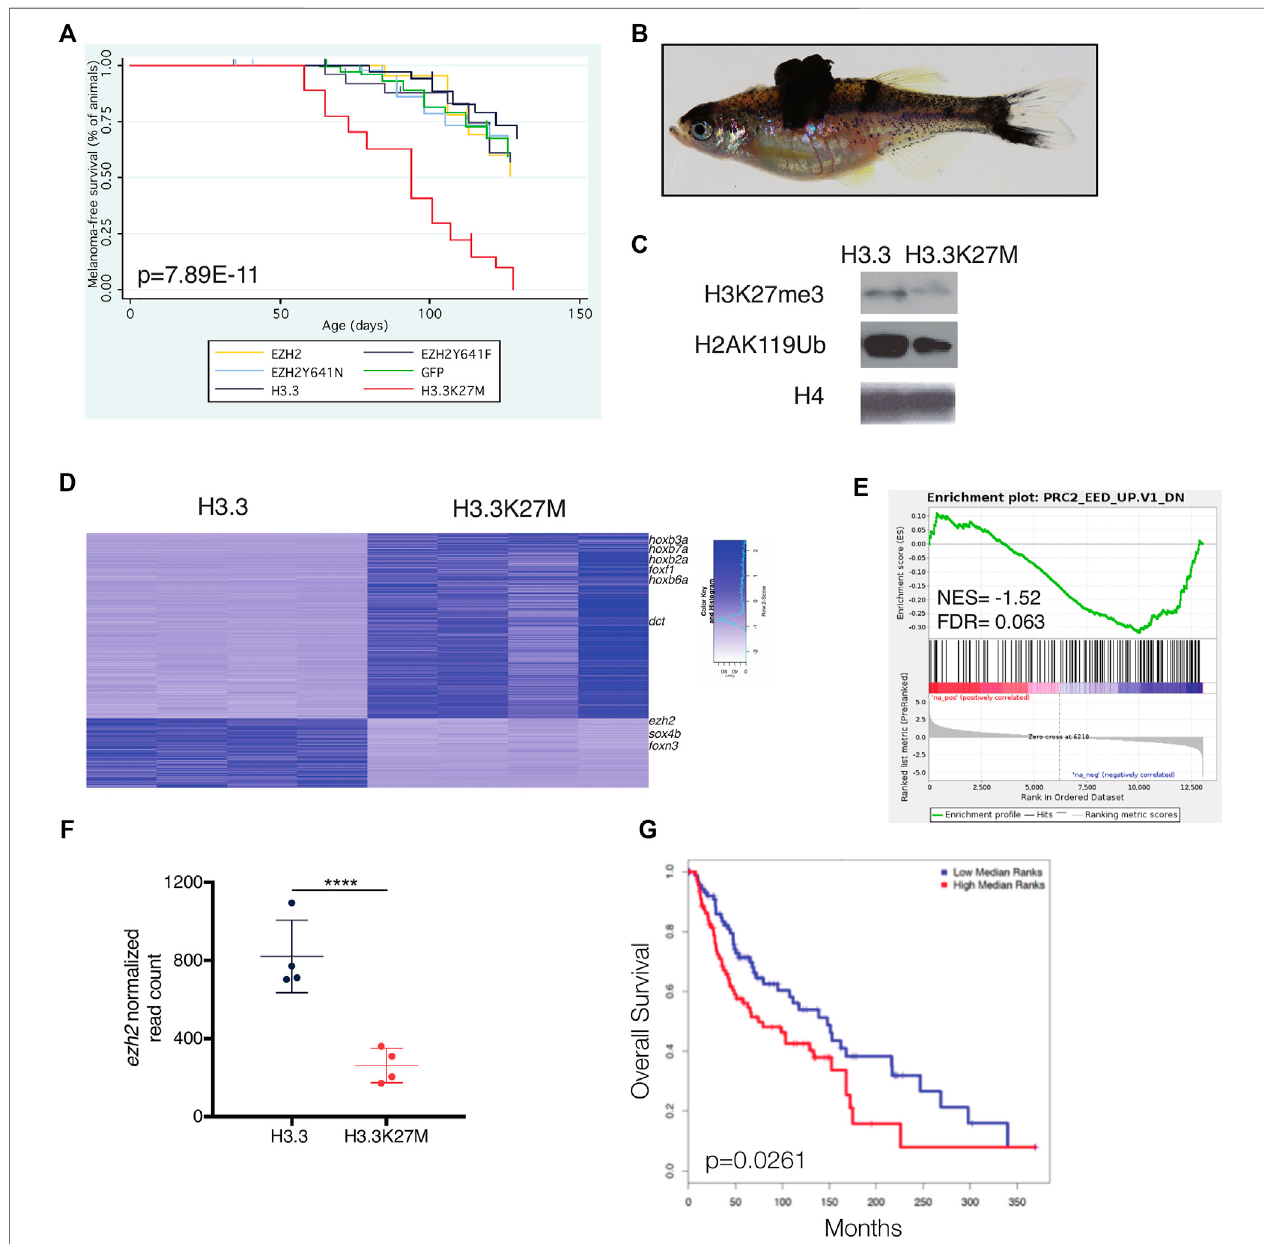
FIGURE 5 | H3.3K27M accelerates melanoma formation. (A) Kaplan-Meier survival curves of Tg(mitfa:BRAF(V600E)); tp53 zdf1/zdf1 ; mitfa w2/w2 zebra fi sh injected with indicated miniCoopR constructs. p value shown calculated from log-rank test between miniCoopR H3.3 and H3.3K27M. (B) Representative tumor-bearing miniCoopR H3.3K27M animal. (C) Western blot of indicated histone marks from miniCoopR H3.3 and H3.3K27M tumors. (D) Top differentially expressed genes between miniCoopR H3.3 and H3.3K27M. Genes with differential expression p < 1E05 are shown. (E) Gene set enrichment analysis (GSEA) of miniCoopR H3.3 and H3.3K27M tumors. NES, normalized enrichment score; FDR, false discovery rate; F, normalized read count of ezh2 from miniCoopR H3.3 and H3.3K27M tumors. p = 6.37E-06, log 2 fold change = − 1.52. (G) overall survival of human melanoma patients ( N = 180) strati fi ed into low (blue) or high (red) expression of 50 gene signature developed from miniCoopR H3.3K27M